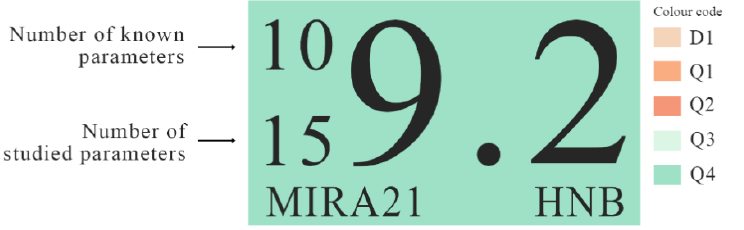
Figure 3. Quantitative description of a catalyst by MIRA21 number with corresponding classifica- tion and color code: D1 (top10%) = linen, Q1 (0 – 25%) = apricot, Q2 (25 – 50%) = light orange, Q3 (50 – cation and color code: D1 (top10%) = linen, Q1 (0–25%) = apricot, Q2 (25–50%) = light orange, 75%) = mint, Q4 (75 – 100%) = turquoise. Q3 (50–75%) = mint, Q4 (75–100%) =